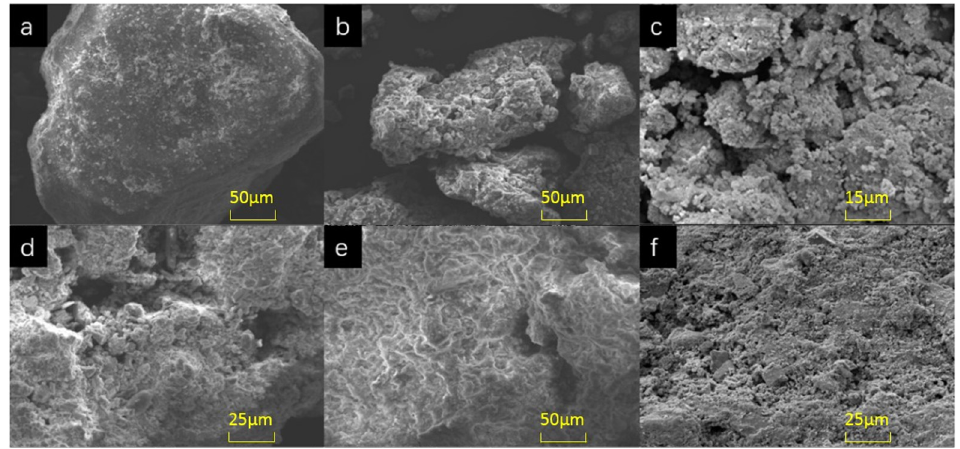
Figure 3. Microscopic morphology of scale samples (( a – f ) represents scale sample ( a ) to sample ( f ), respectively).